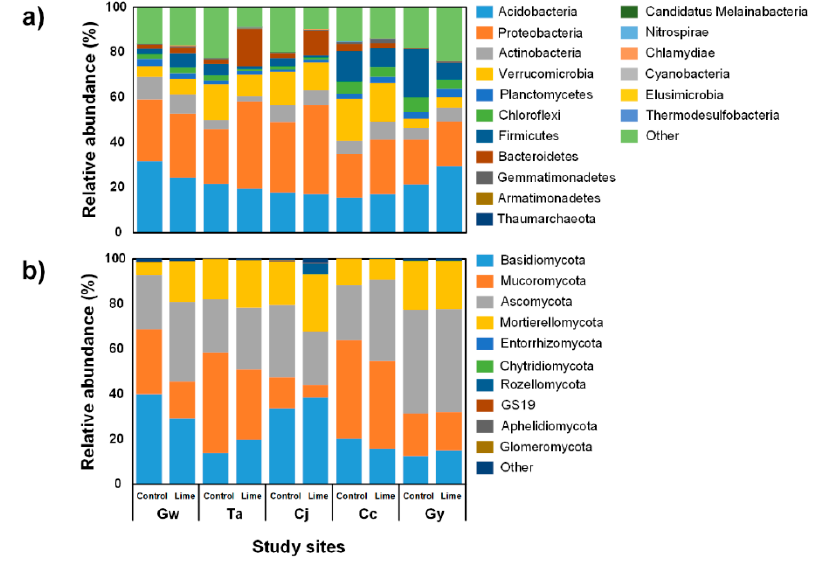
Figure 2. Relative abundance of soil bacterial phyla ( a ) and fungal phyla ( b ) at the study sites.